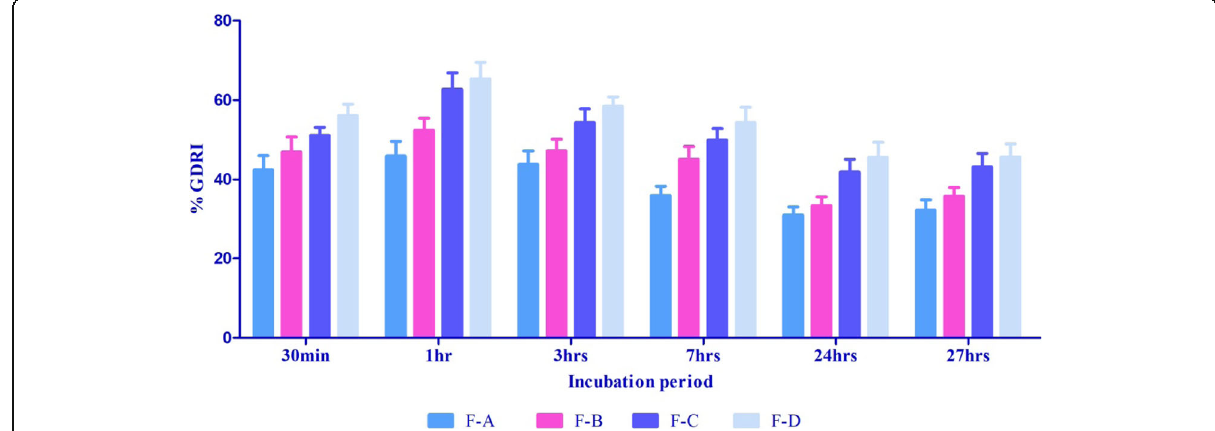
Fig. 6 Effect of isolated pooled fractions from MeCV on the percentage of GDRI. The vertical bars represented as mean ± SD for n = 6